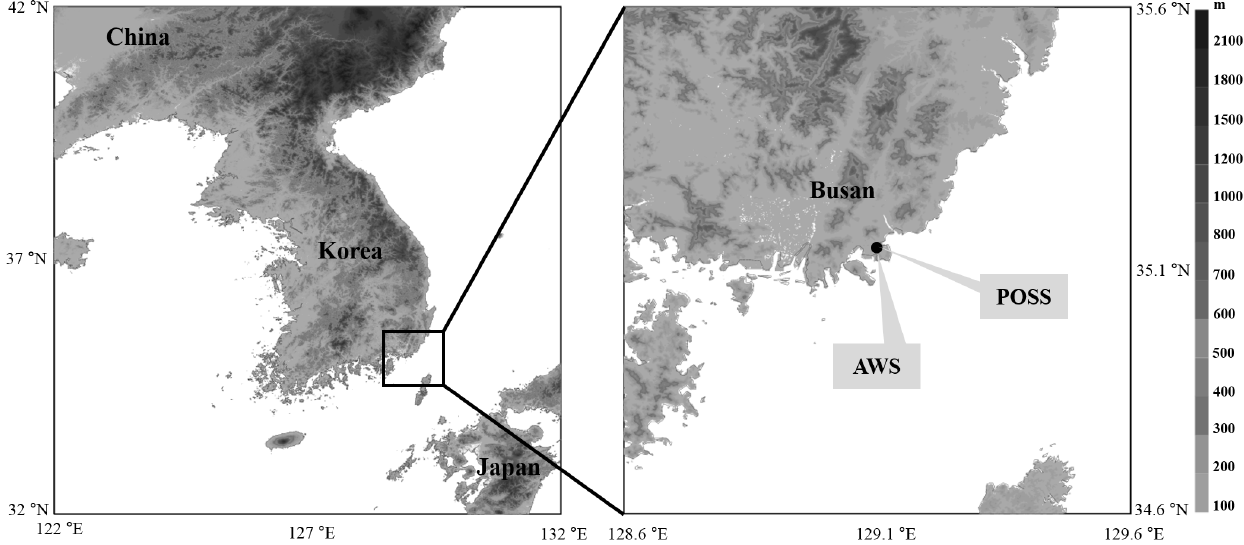
Figure 2. Locations of the POSS and the AWS rain gauge installed in Busan, Republic of Korea.